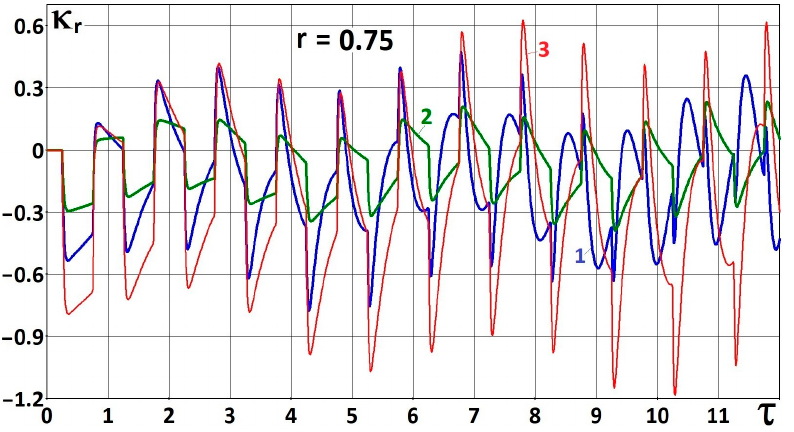
Figure 14. Time history of the relative radial stress at r = 0.75. Elastic materials. FGM cylinder—curve 1; two-layer cylinder—curve 2; homogeneous cylinder—curve 3.